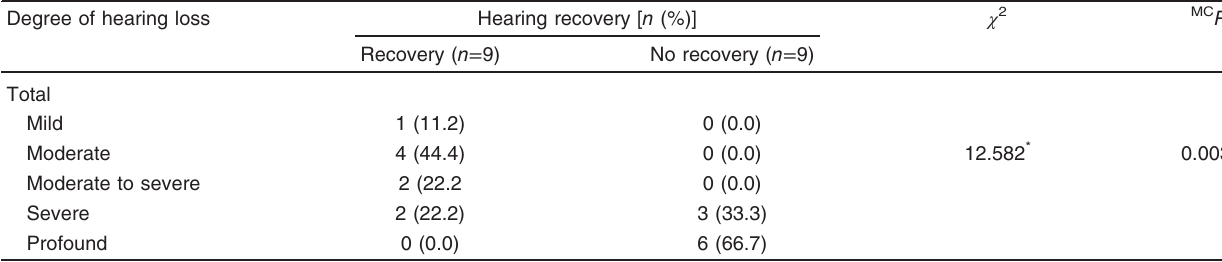
Table 3 Relation between hearing recovery and degree of hearing